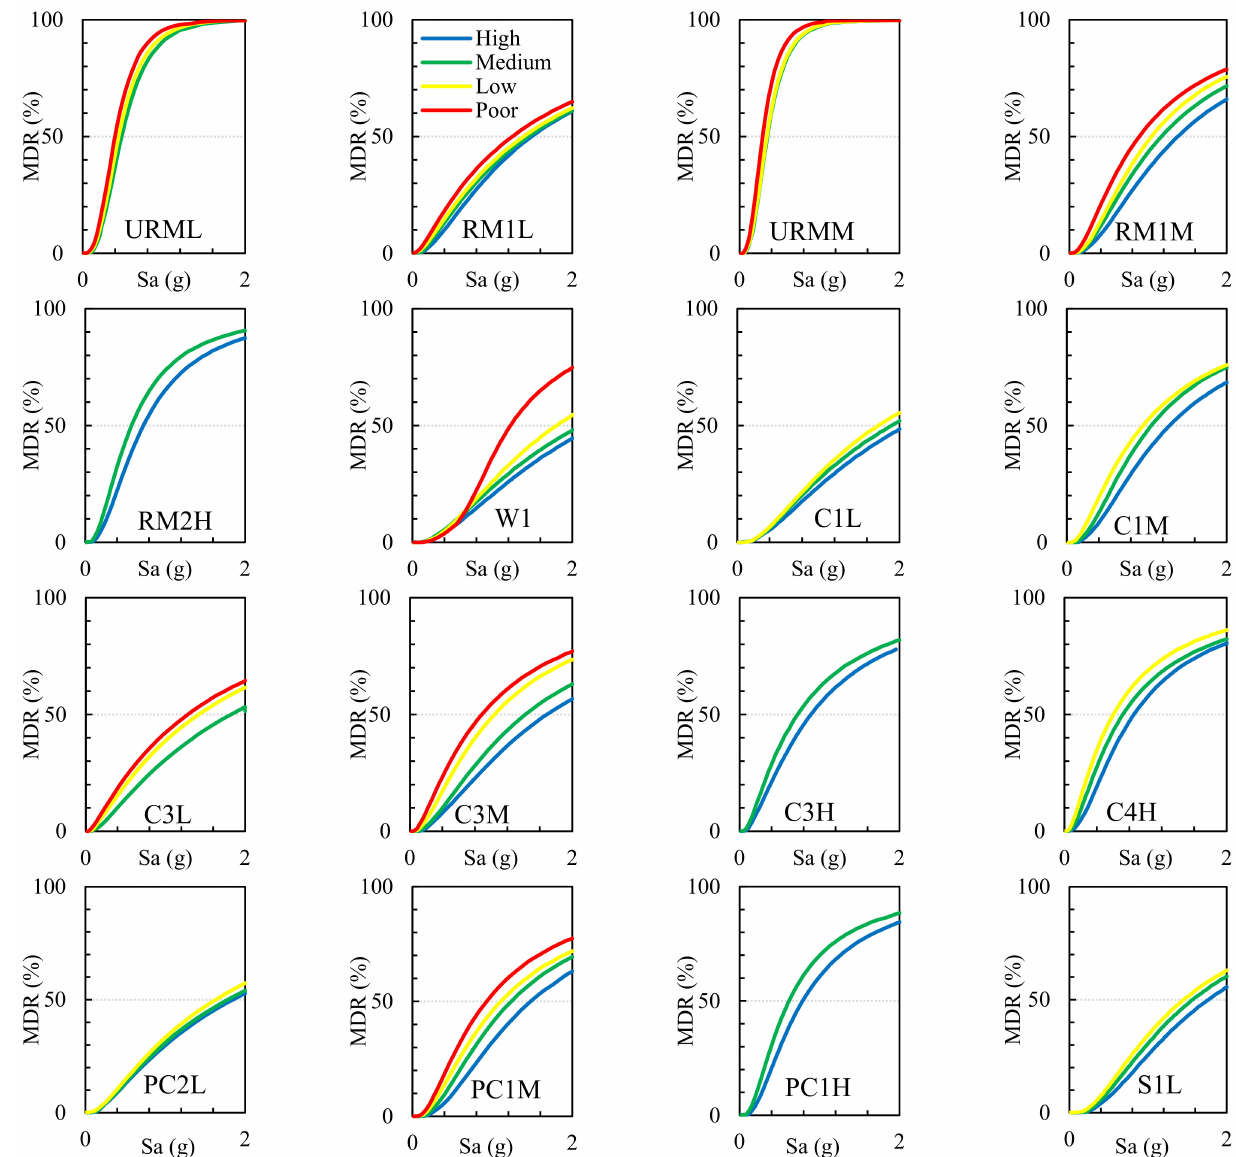
Figure 10. Vulnerability functions of GAR-13 were used in this